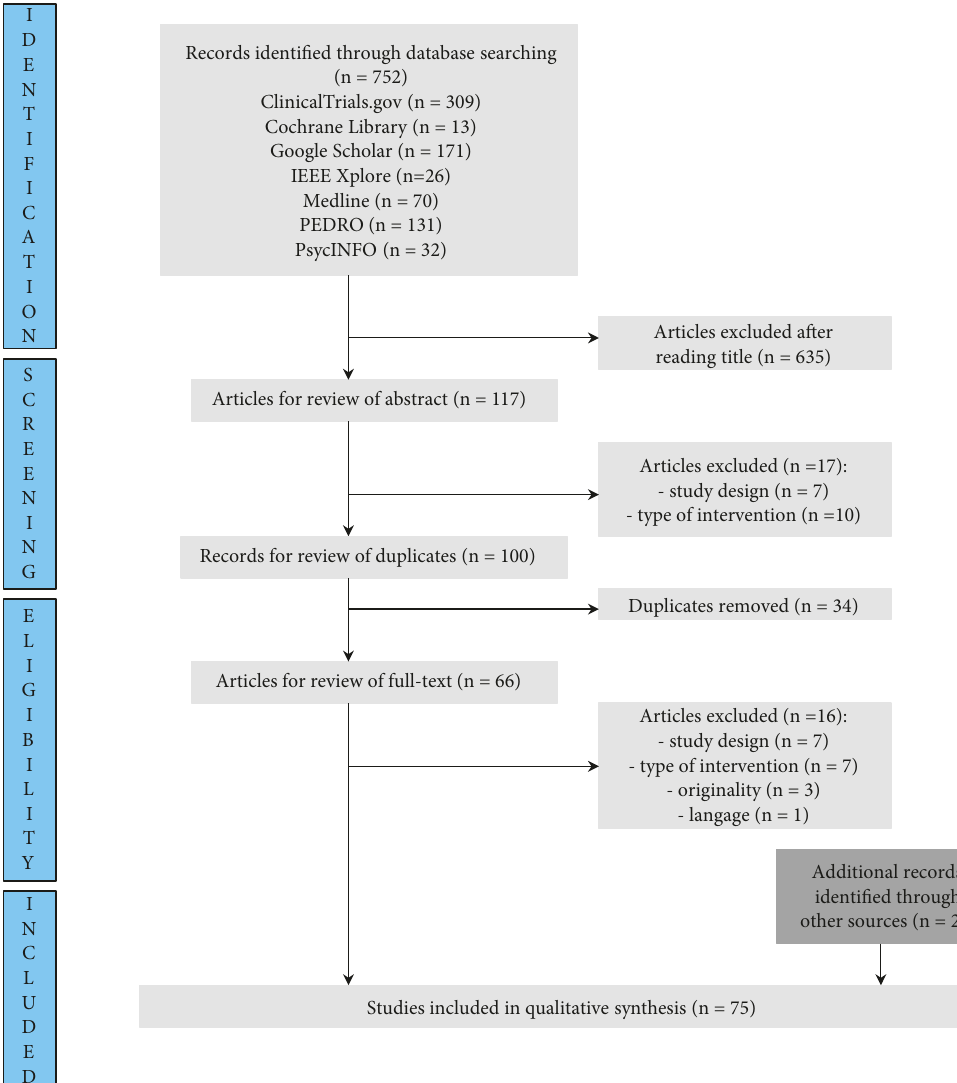
Figure 1: Flow chart of the study selection process.